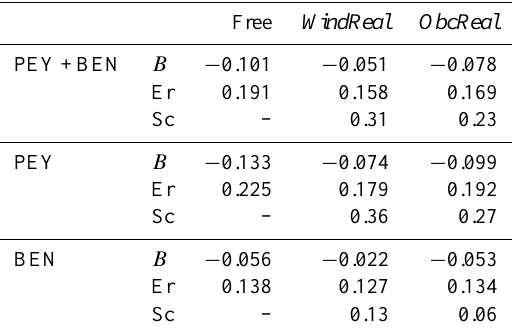
Table 1. Radial velocity statistics for the PEY, BEN and both (PEY+BEN) radar stations computed for the free, WindReal and ObcReal runs in relation to the observation over the entire assimila- tion period. B and Er are in ms − 1 . Sc is without unit. Free WindReal ObcReal